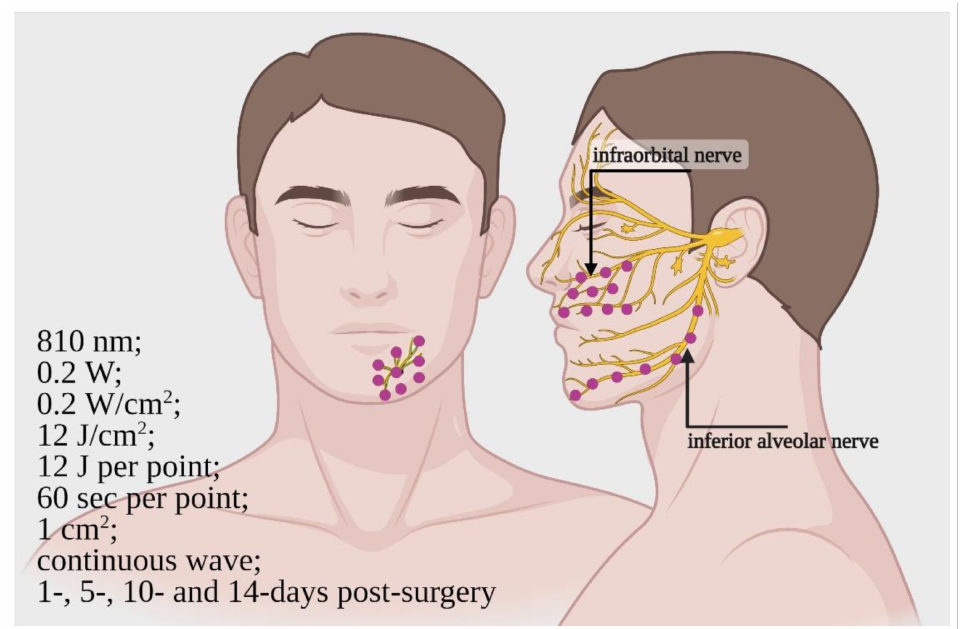
Figure 3. Design of the irradiation, site of irradiation and parameters, performed by Haghighat et al. [47], on patients affected by inferior alveolar nerve and infraorbital nerve damages after bilateral sagittal split osteotomy and Le Fort 1 osteotomy. Image created with